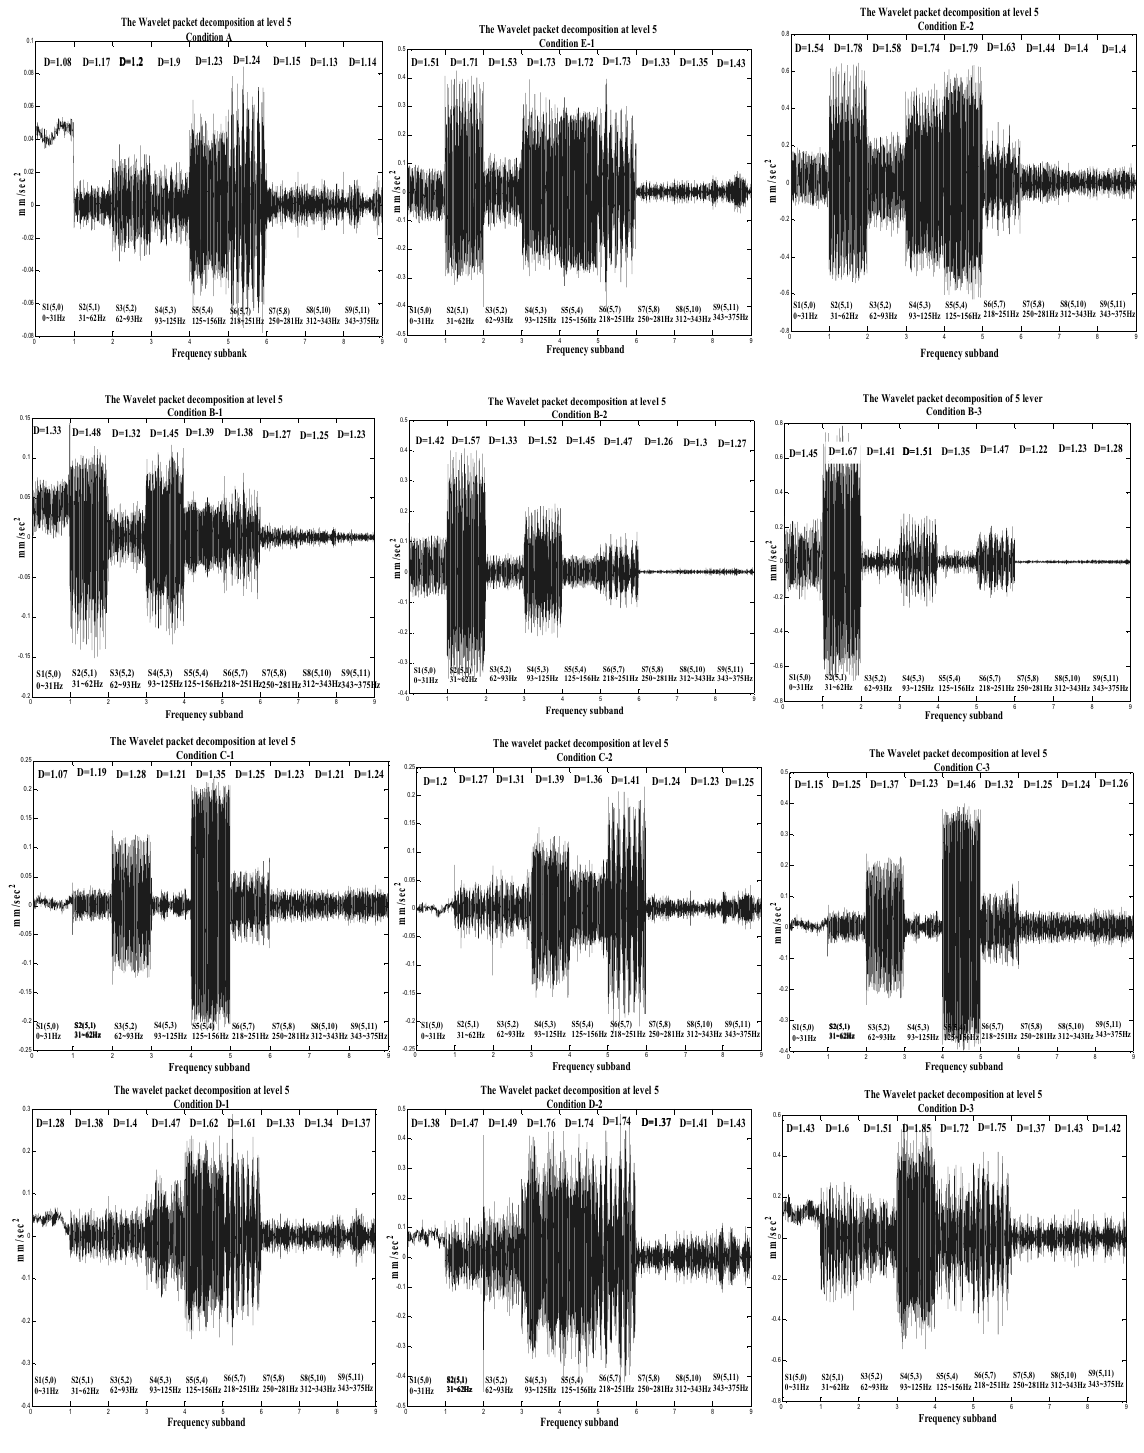
Fig. 11. The wavelet packet decomposition